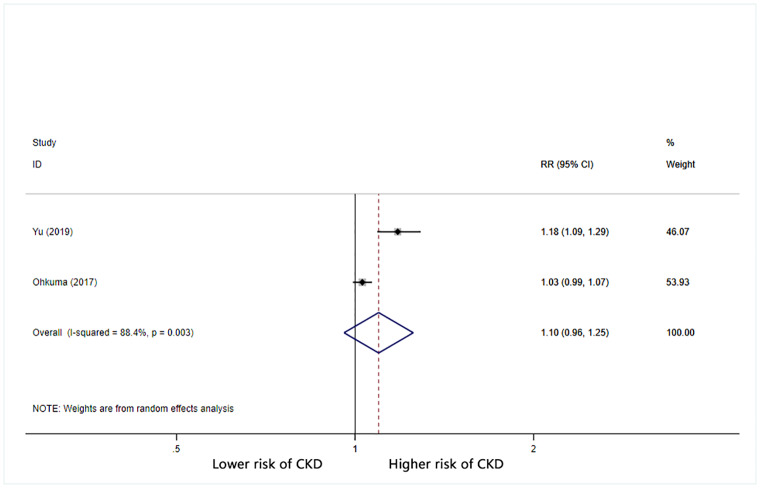
Forest plot of relationship between 1 increment in VIM-SBP and risk of CKD.Boxes represent the Relative risk (RR) and lines represent the 95% Confidence Intervals (CIs) for individual studies. The area of each square is proportional to study weight. The diamonds and their width represent the pooled RRs and the 95% CIs, respectively.